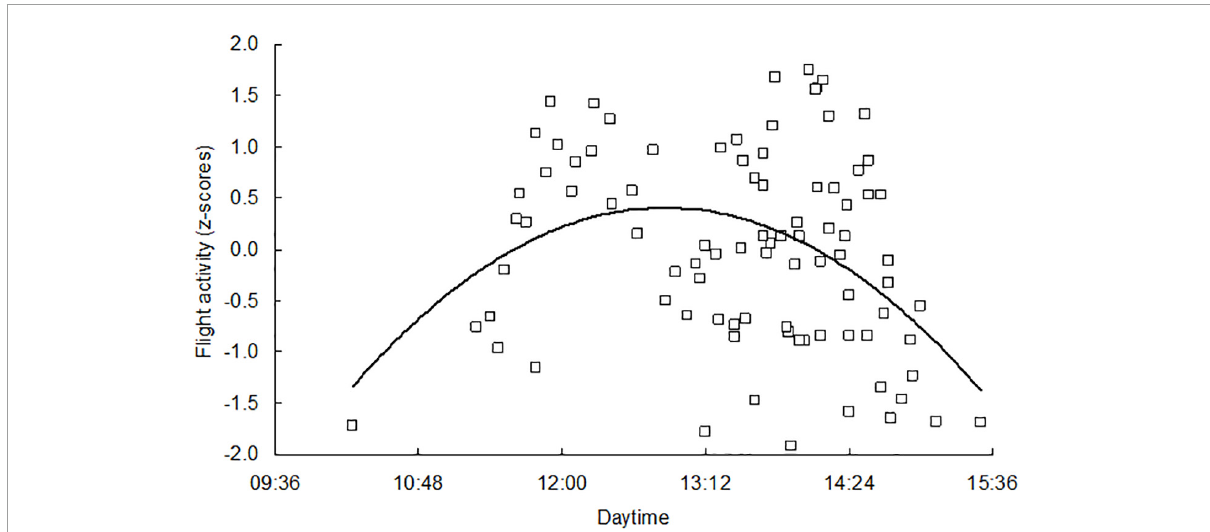
FIGURE3 Flight activity of adults immigrating to overwintering sites, aggregate data from 2013 to 2021. Individual symbols indicate the number of adults sampled per 1 min on a standard section of facade (Nt transformed as z scores) on days of mass flight to overwintering sites (shaded symbols in Figure 2 ). Fitted by second order polynomial y = –147.38x 2 + 157.95x–41.91, N = 89, R 2 = 0.1537, P = 0.001.